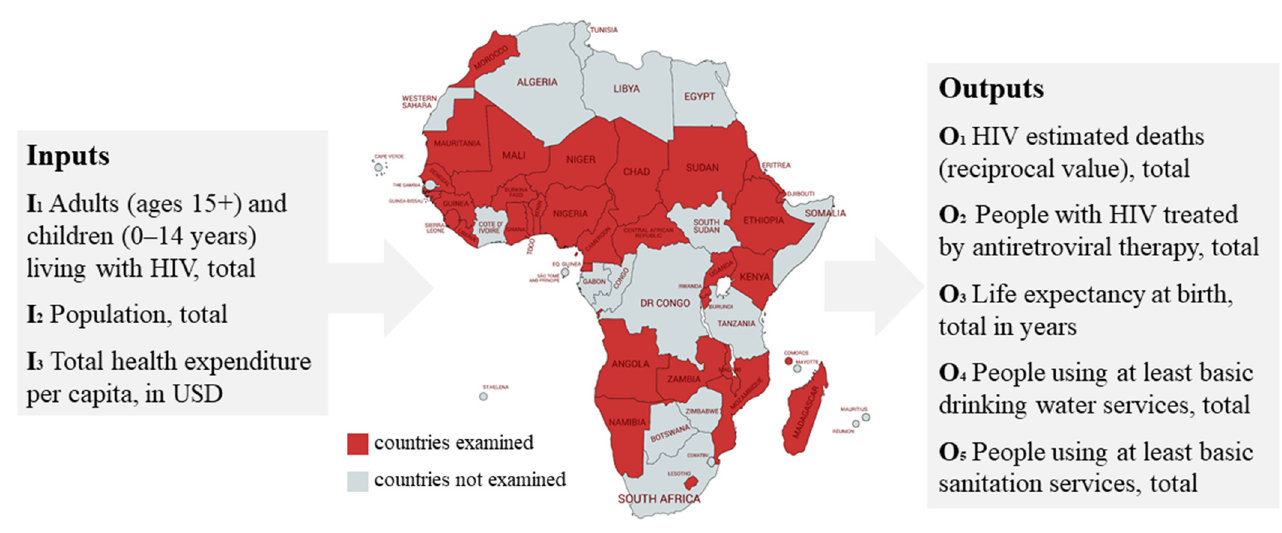
Figure 1. Data envelopment analysis (DEA) model for national governments and agencies. As outputs, the estimated deaths related to HIV (O 1 ) and the number of people with HIV treated by antiretroviral therapy (O 2 ), were used to address the input of the total amount of adults (ages 15+) and children (0–14 years). Including the estimated deaths related to HIV as an output factor within DEA requires its integration as a reciprocal value, because otherwise, a large number of deaths are interpreted as efficient by the DEA calculation: Output value for deaths related to HIV by decision making unit (DMU) DMU n in t m = max. deaths related to HIV for all DMU in a dataset in tm—deaths related to HIV of DMU n in tm. A third output is the life expectancy at birth in years (O 3 ), aiming to ex- press the effect of the overall health support beyond existing age groups. In order to take populations’ security of supply into account, the number of people using at least basic drinking water services (O 4 ) and of people using at least basic sanitation services (O 5 ) were